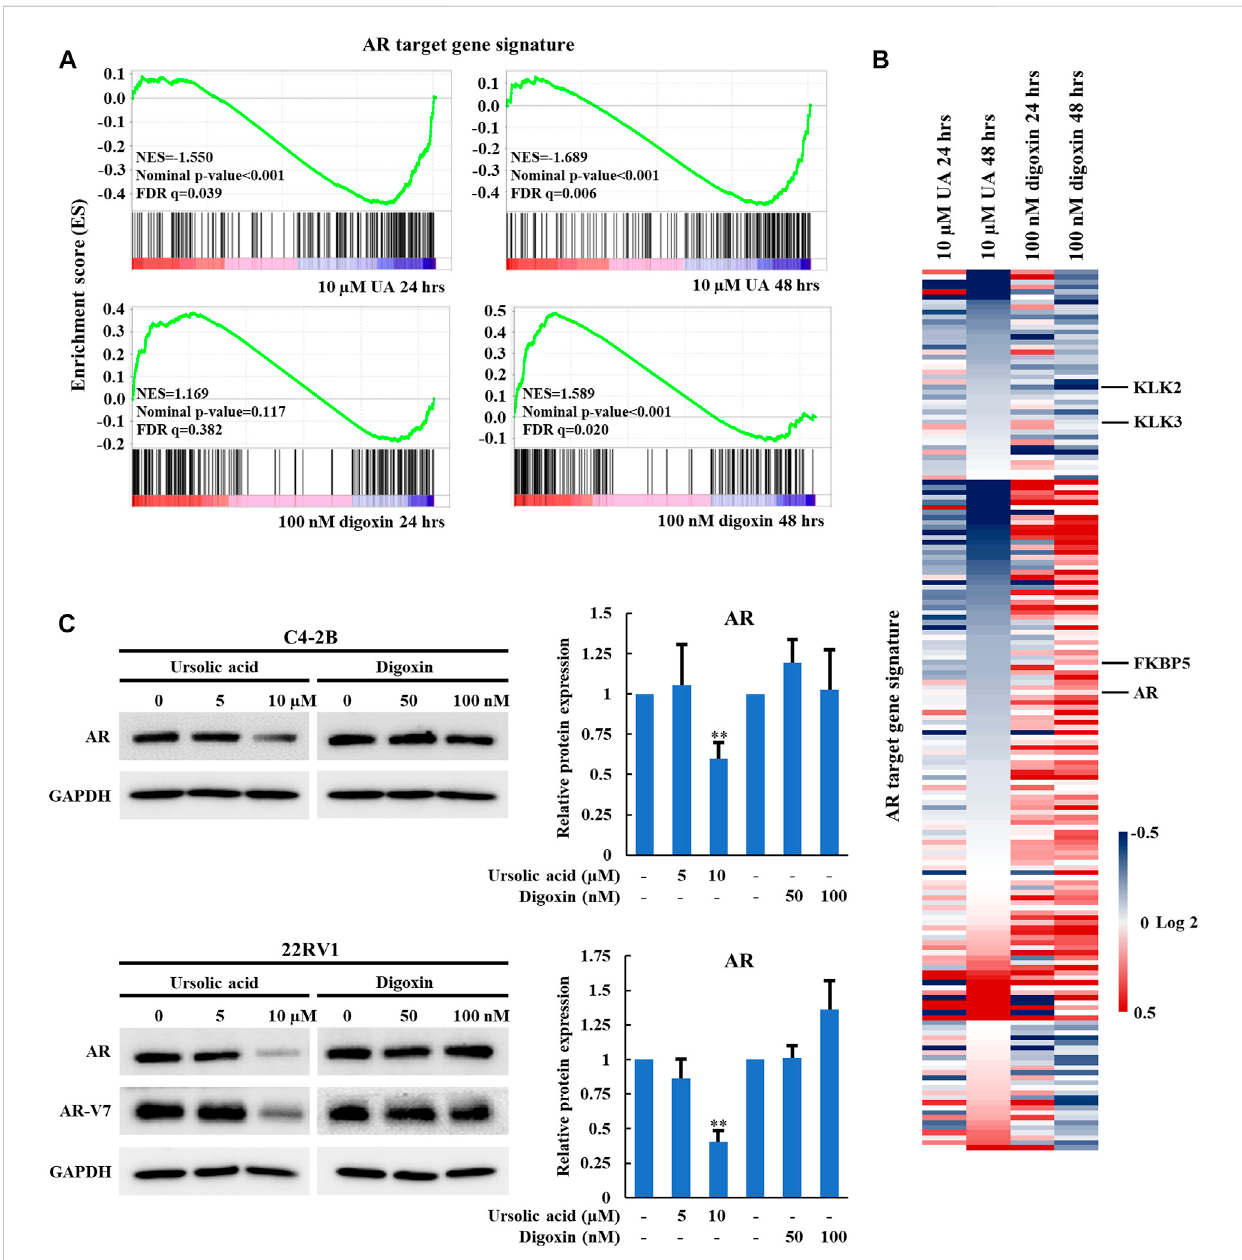
FIGURE 3 UA but not digoxin inhibits AR expression and AR-signaling in PCa cells. (A) . GSEA of the AR signaling pathway in C4-2B cell treated with UA (10 µM) or digoxin (100 nM) for 24 or 48 h. NES, normalized enrichment score. FDR, false-discovery rate. (B) . Heat map display of fold changes (in log2) of AR- signature gene mRNA analyzed by RNA-seq in C4-2B cell treated with UA (10 µM) or digoxin (100 nM) for 24 or 48 h. (C) . Immunoblotting of AR (full length) in C4-2B cell, AR (full length) and AR-V7 in 22RV1 cell treated with UA or digoxin at indicated concentration for 48 h (left). Quanti fi cation of Western blotting (right). AR expressions were normalized to that of GAPDH. Data are shown as mean ± SD. n ≥ 3. Student ’ s t-test. ** p <